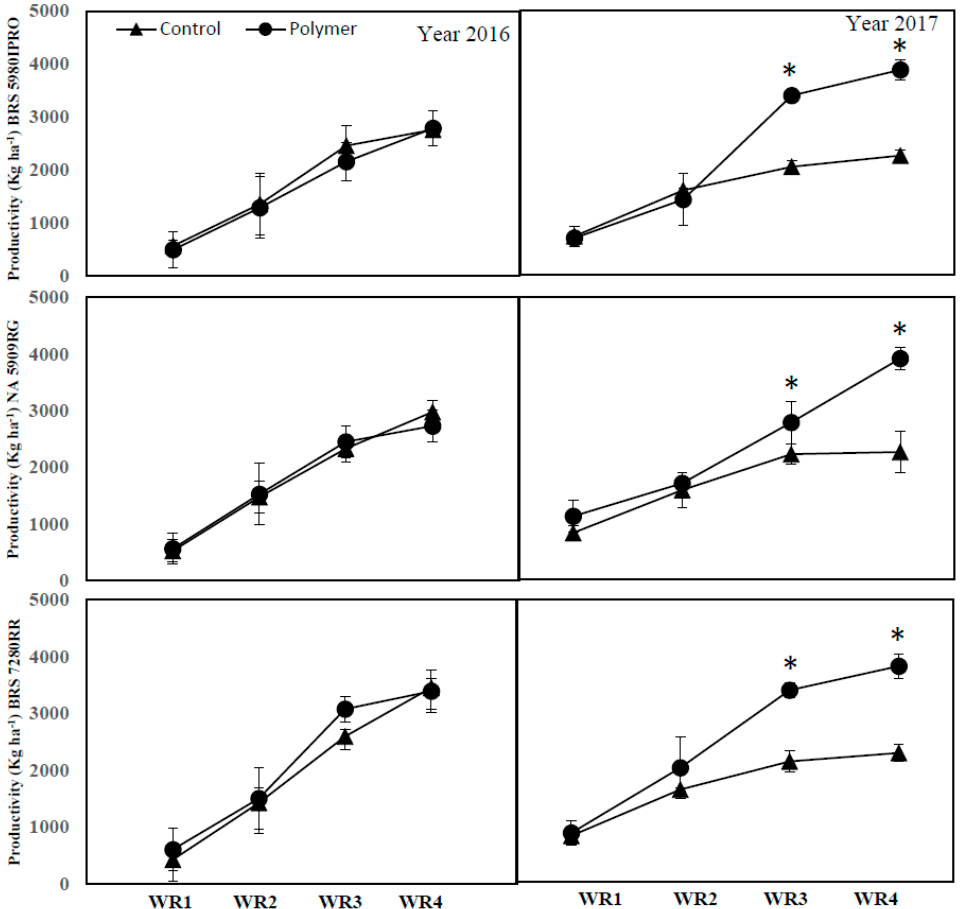
Figure 8. Productivity (Kg ha − 1 ) in three soybean cultivars submitted to four water regimes WRs. control (triangles) and polymer-treated (circles) in 2016 and 2017. * indicates significant differences between control and polymer-treated plants by Tukey’s test ( p < 0.05) (WR1 157 mm, WR2 263 mm, WR3 432 mm and WR4 630 mm in 2016; WR1 167 mm, WR2 237 mm, WR3 341 mm and WR4 534 mm in 2017).